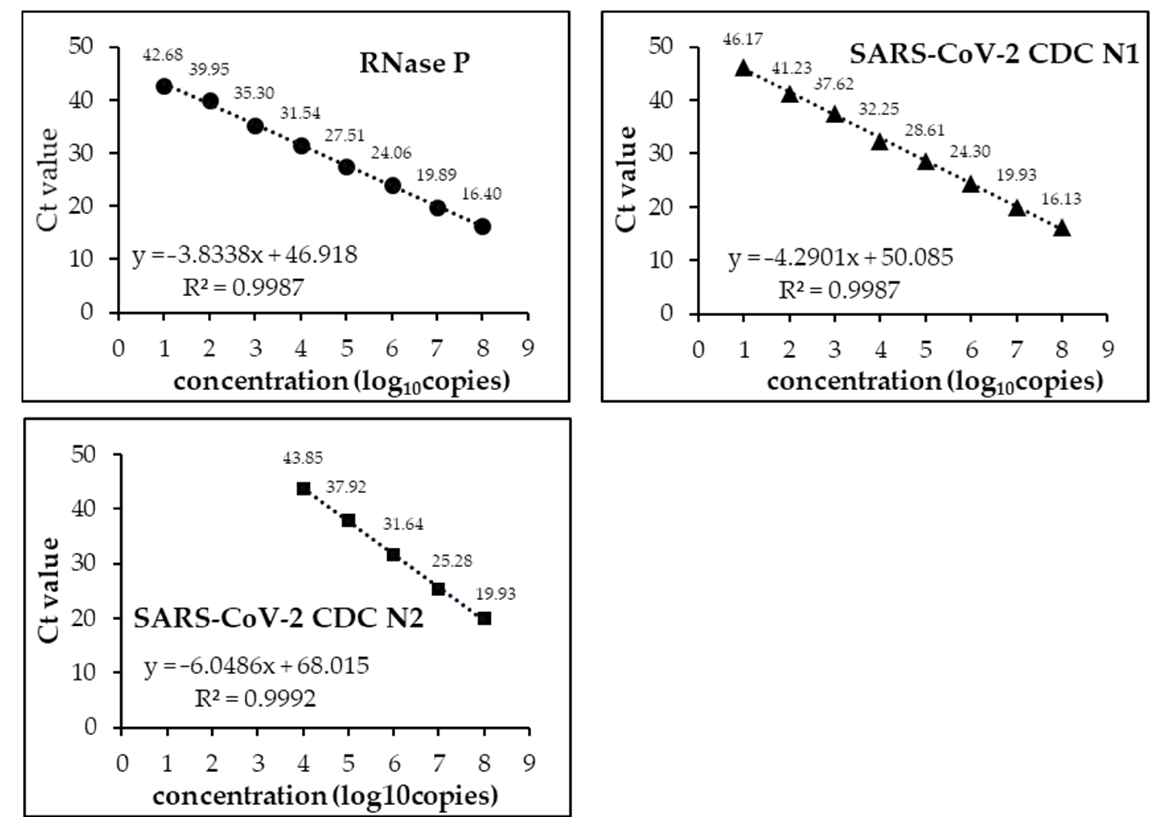
Figure 2. The correlation of each concentration of synthetic RNA and Ct value when the PCR1100 device was utilized to detect with multichannel. The Ct value against each concentration is demonstrated by the number above each symbol. x: log 10 copies; y: Ct value.